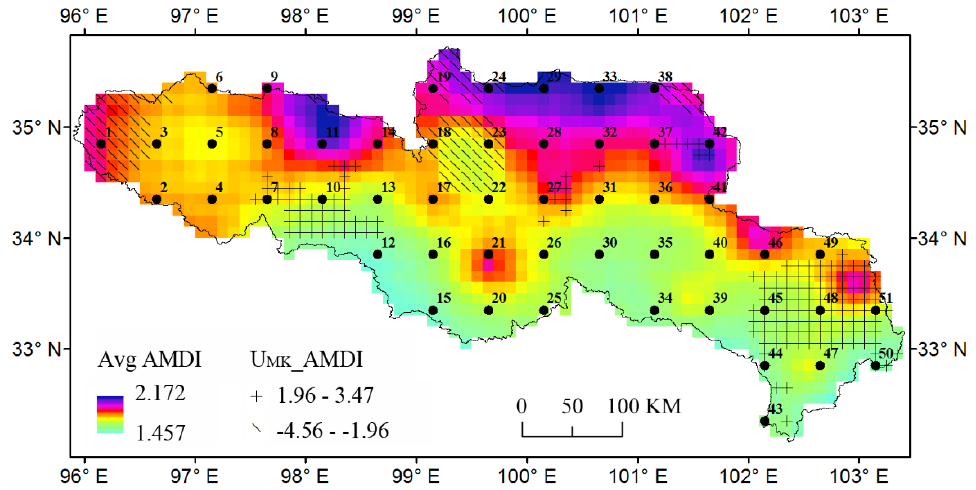
Figure 7. The spatial distribution of the multi-year average AMDI (annual marginal disorder index) based on daily precipitation and its significant trends by the M–K test during 1979–2015 over the SRYR.